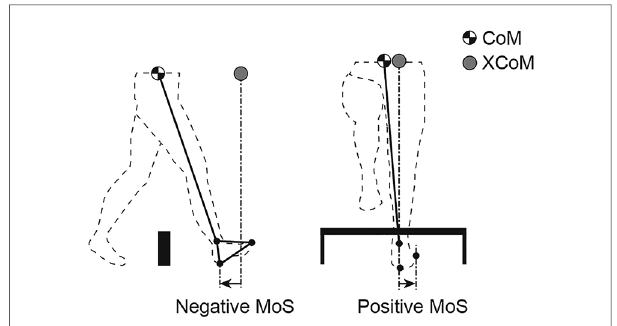
FIGURE 2 De fi nition of the margin of stability (MoS). The extrapolated center of mass (XCoM) was derived from the position and velocity of the center of mass (CoM). MoS in the anteroposterior (AP) direction was de fi ned as the heel position minus the XCoM at the time of heel contact. The MoS in the mediolateral (ML) direction was de fi ned as the minimum distance from the small toe or heel position minus the XCoM. A positive MoS indicates dynamic stability. A negative MoS indicates that the walker would theoretically need an extra step to ensure that the CoM remained within the base of support